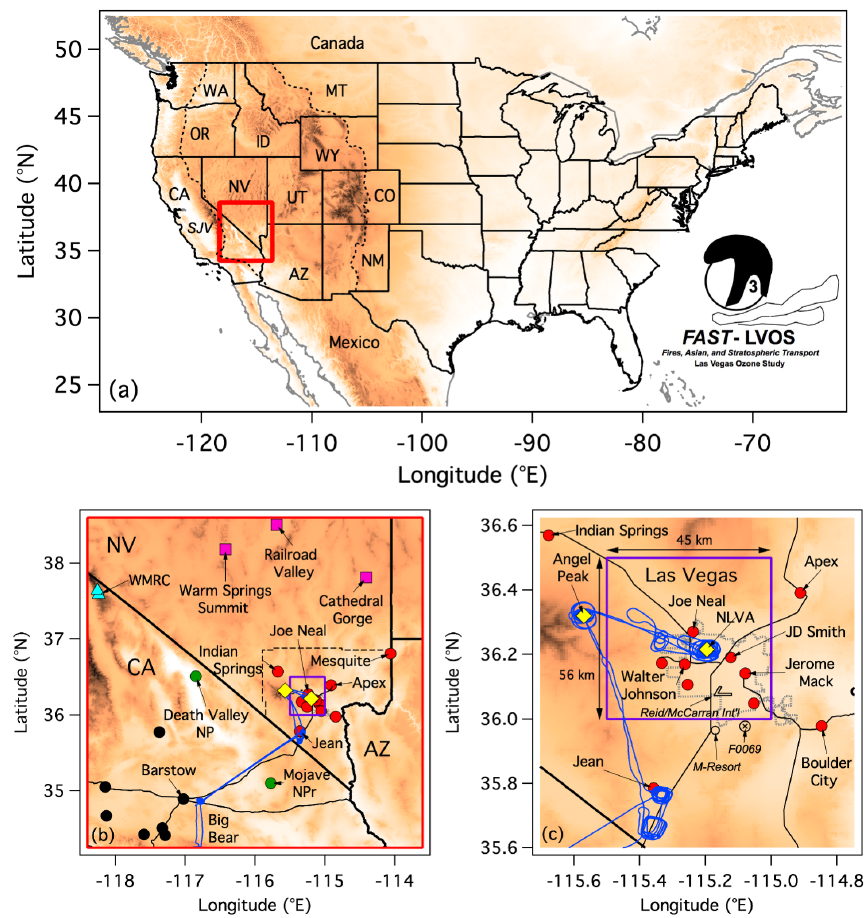
Figure 1. (a) Shaded relief map of the contiguous US showing the FAST -LVOS study domain (red box). The dashed black line outlines the US Intermountain West. The San Joaquin Valley (SJV) was studied the previous summer in the CABOTS field campaign. (b, c) Expanded views of the study area. The solid and dashed black lines in (b) mark the state and Clark County borders, respectively. The dotted black line in (c) outlines the Las Vegas metropolitan area. The color-filled circles mark regulatory O 3 monitors maintained by Clark County (red), the US National Park Service (green), and the California Air Resources Board (black). The magenta squares and cyan triangles show baseline monitors operated by the Nevada Department of Environmental Quality and White Mountain Research Center, respectively. The yellow diamonds show the locations of Angel Peak (AP) and the North Las Vegas Airport (NLVA; see text). The blue traces show the 28 June SA flight track, and the violet boxes outline the 0.25 ◦ × 0.25 ◦ ( ≈ 45km H × 56km W) FLEXPART receptor